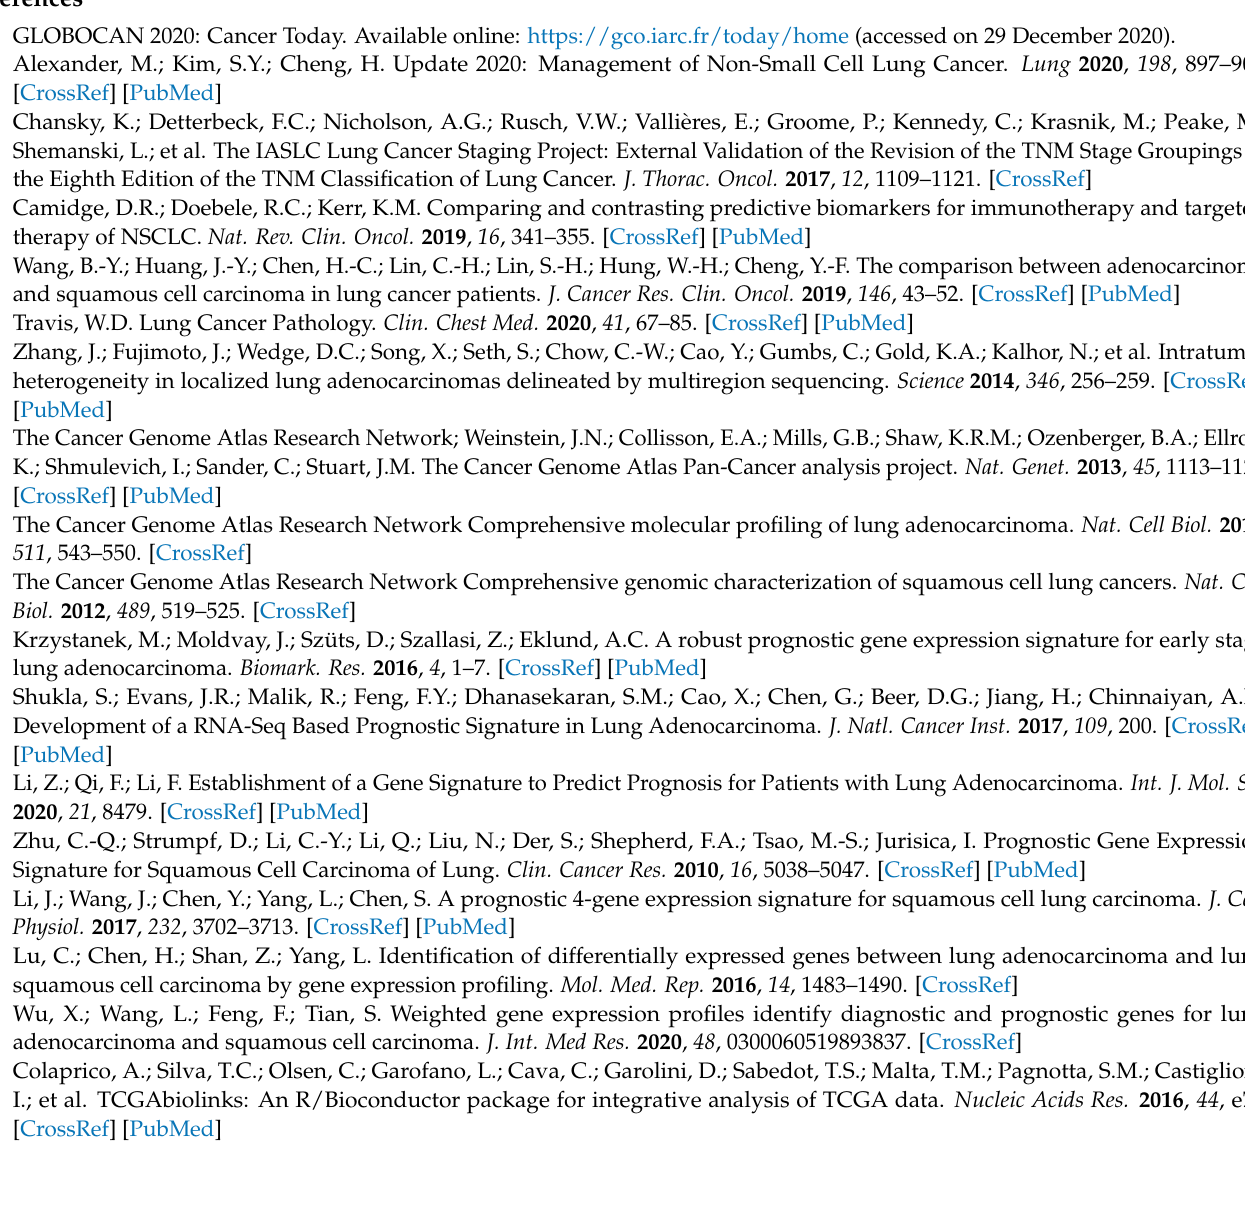
Table S6: SomInaClust result of SNV data in tumor samples of LUAD high-risk group; Table S7: SomInaClust result of SNV data in tumor samples of LUSC low-risk group; Table S8: SomInaClust result of SNV data in tumor samples of LUSC high-risk